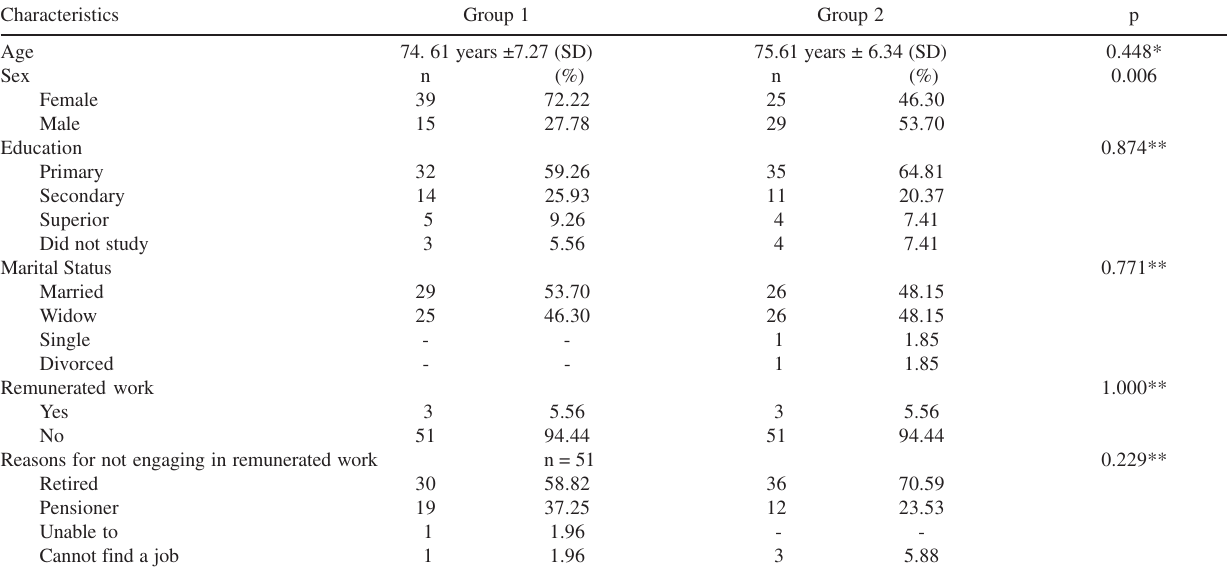
Table 1 - Sociodemographic characteristics of patients with age-related macular degeneration with monocular (Group 1) and binocular (Group 2) legal blindness at the University of Sao Paulo General Hospital in 2006. Characteristics